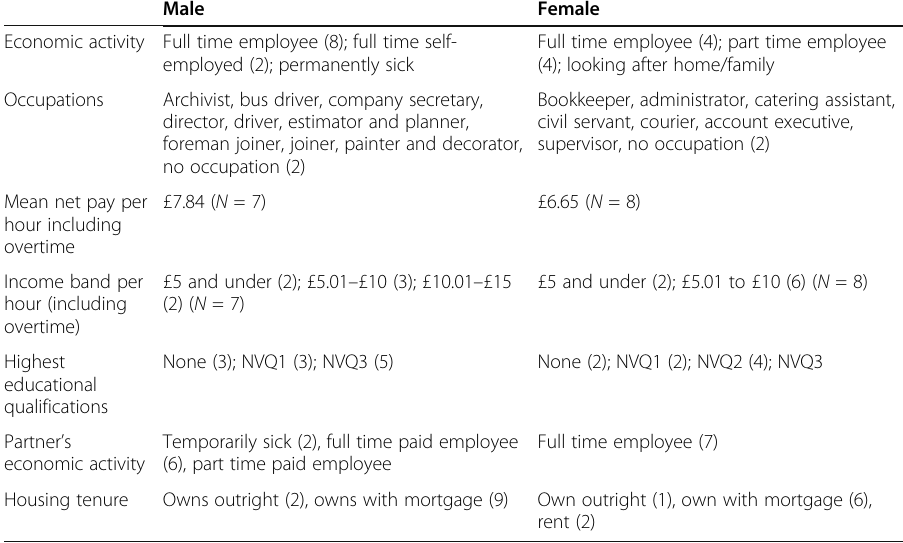
Table 1 Details of the 20 disadvantaged respondents from NCDS ( N = 20 unless otherwise stated, where there is missing data)